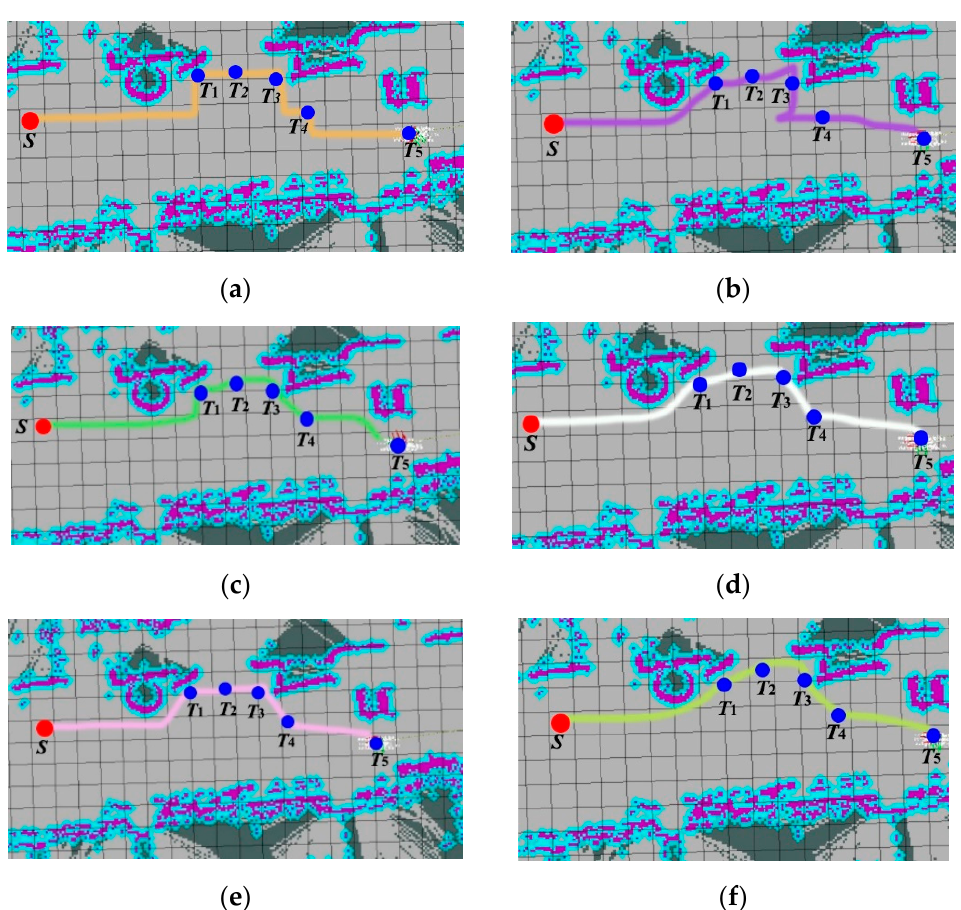
Figure 13. Comparison of the application of the path planning algorithms in a real scenario: ( a ) Dijkstra algorithm; ( b ) Floyd algorithm; ( c ) 8-search-neighborhood A* algorithm; ( d ) 24-search- neighborhood A* algorithm; ( e ) 48-search-neighborhood A* algorithm; ( f ) 48-search-neighborhood